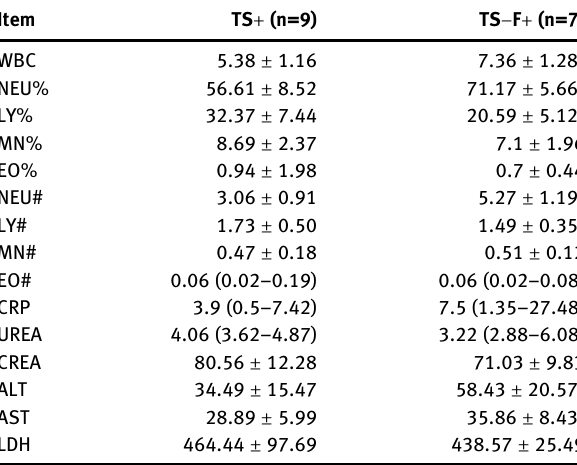
Table  : Comparison of some blood indices between the throat swab-positive (TS + ) group and the throat swab-negative but fecal- positive (TS − F + )